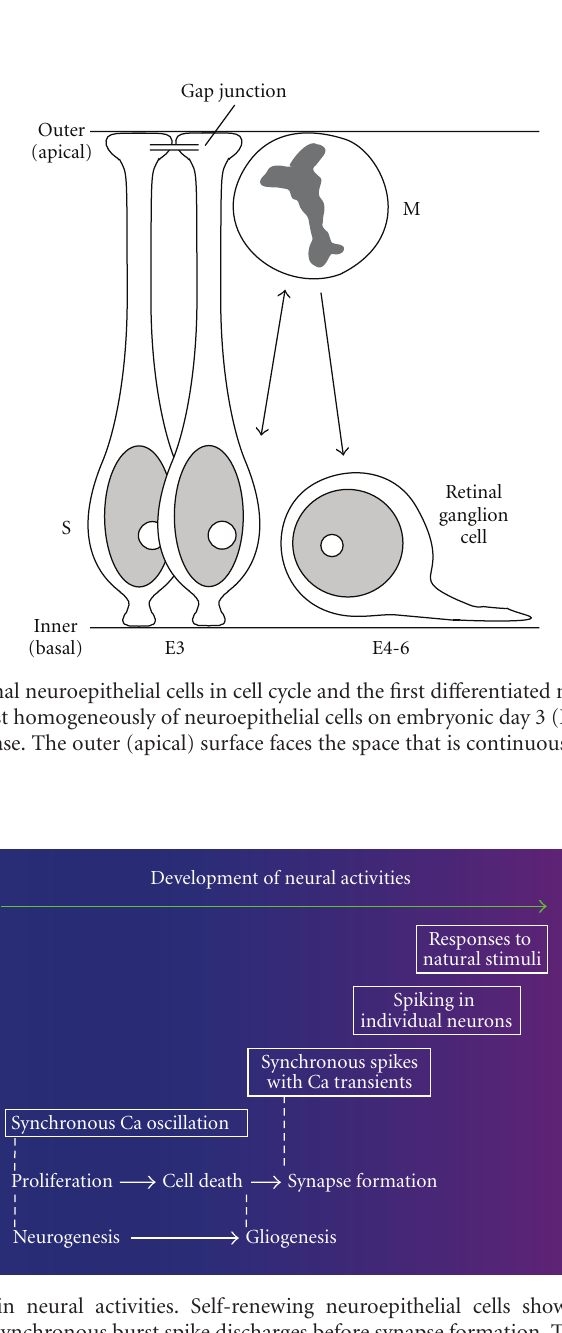
muscarinic acetylcholine receptors [7], P2Y